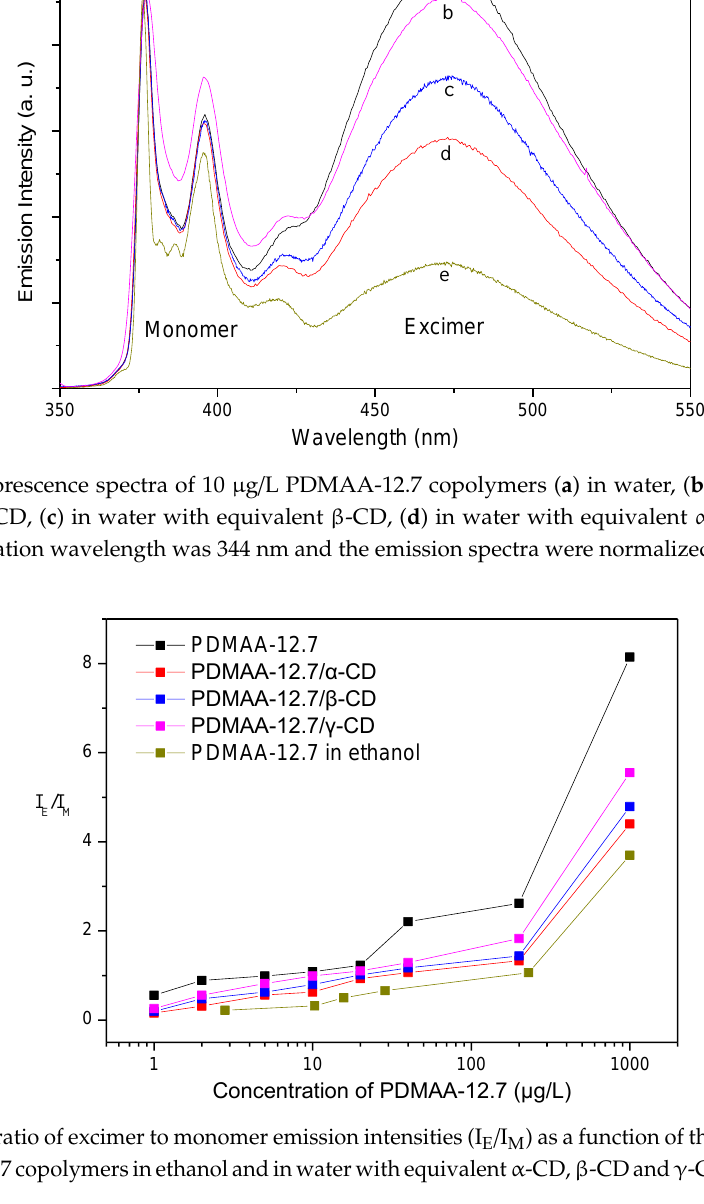
Figure 5. Fluorescence spectra of 10 μg/L PDMAA-12.7 copolymers ( a ) in water, ( b ) in water with equivalent γ-CD, ( c ) in water with equivalent β-CD, ( d ) in water with equivalent α-CD and ( e ) in ethanol. Excitation wavelength was 344 nm and the emission spectra were normalized at 377 nm.